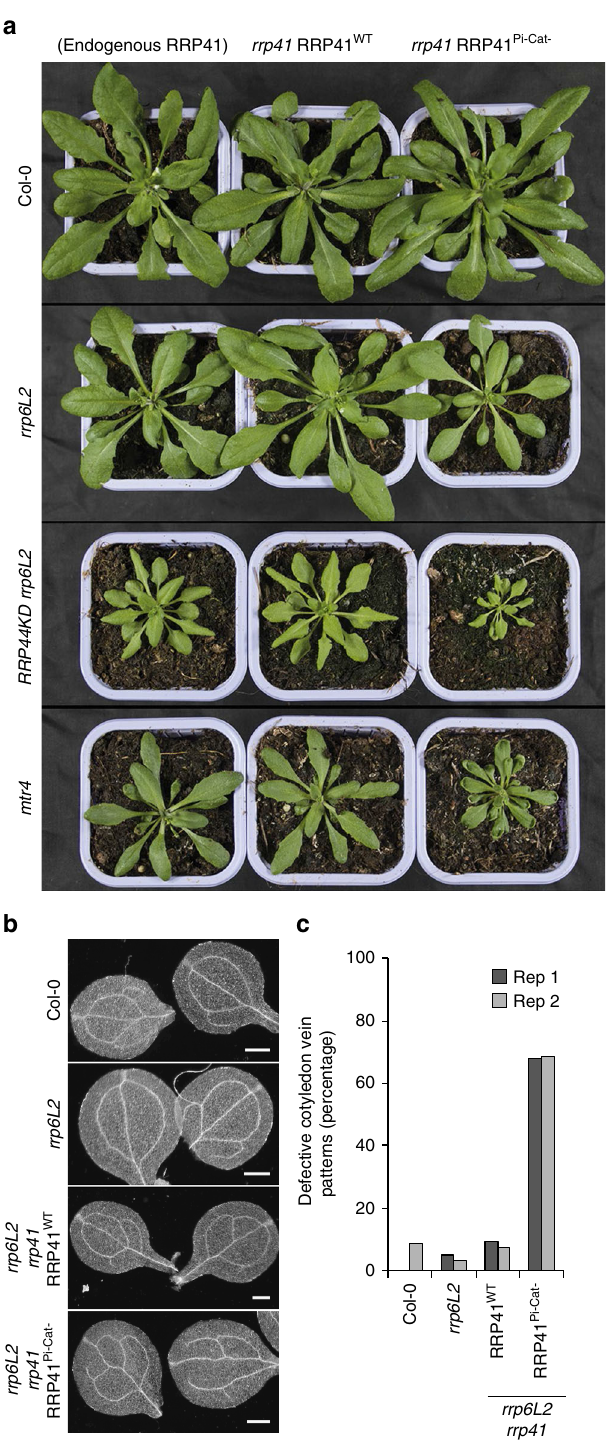
Fig. 6 Phenotype of Exo9 activity mutants. a Plants expressing